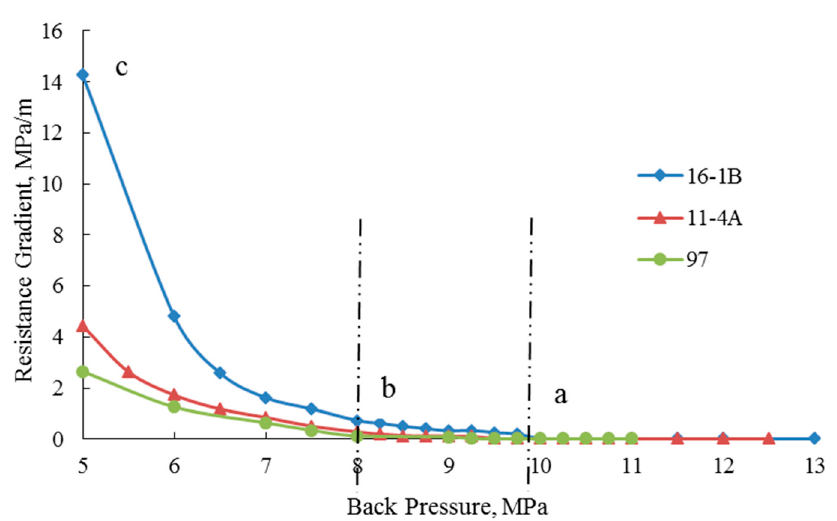
Figure 6. Relationship between the back pressure and the porous flow resistance gradient.